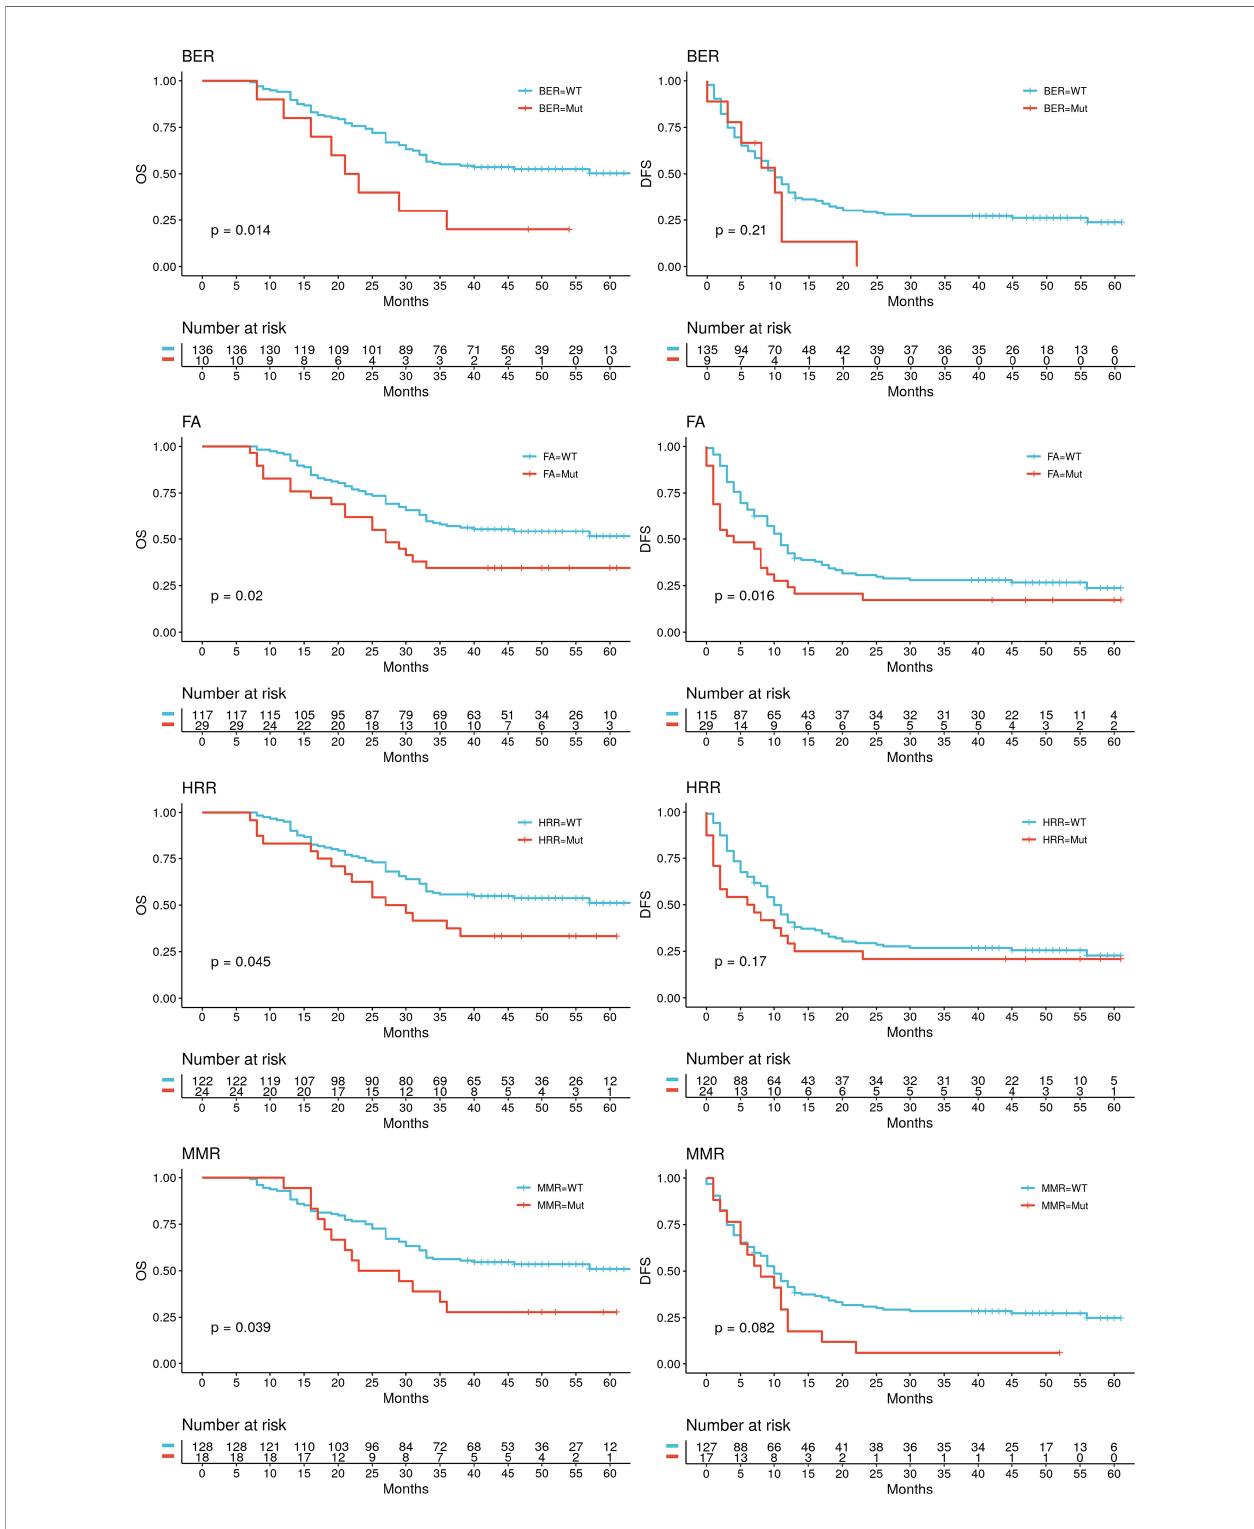
FIGURE 3 | Kaplan-Meier curves of survival differences in patients with or without mutations in certain DDR pathways. OS in four of the DDR pathways showed signi fi cant differences between the mutated and wildtype patients: BER, FA, HRR and MMR. The patients carrying mutations in these four pathways are statistically having shorter OS and thus poorer prognosis than the wildtype ones. DFS in patients with or without mutations in the above pathways showed no signi fi cant difference, except for the FA pathway. The curves of other pathways without any signi fi cance in results are attached in Supplementary Figure 3 .